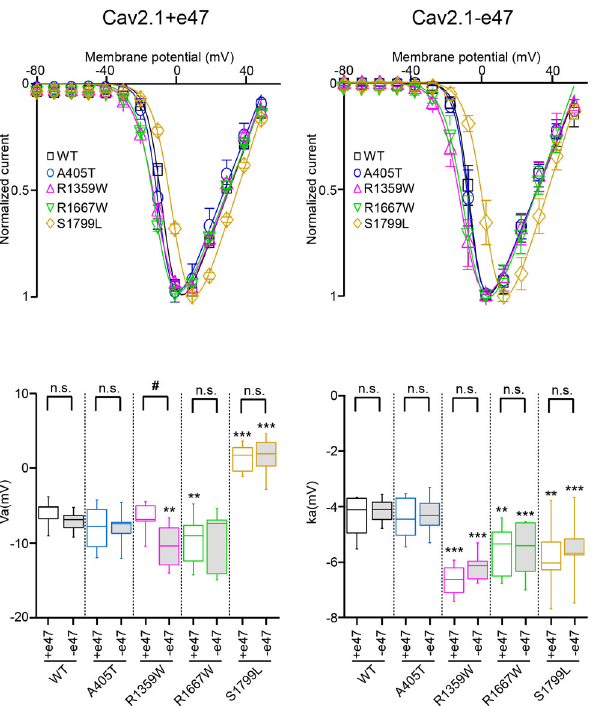
Figure 3. Voltage dependence of Cav2.1 activation. ( Top ) Average current-voltage relationships for X. laevis oocytes expressing Cav2.1+47 ( left ) or Cav2.1 − e47 variants ( right ). ( Bottom ) Box plots of half-maximal activation potential (Va, left) and slope factor of the Boltzmann curve of channel activation (ka, right) were obtained for all Cav2.1 variants studied. The mean values are given in Table 1. Asterisks and number signs denote significant differences vs. WT (** p < 0.01, *** p < 0.001) and vs. Cav2.1+e47 splice variant (# p < 0.05), respectively (non-paired Student’s t -test). n.s. = non-significant. Table 1. Voltage dependence of Cav2.1 activation and